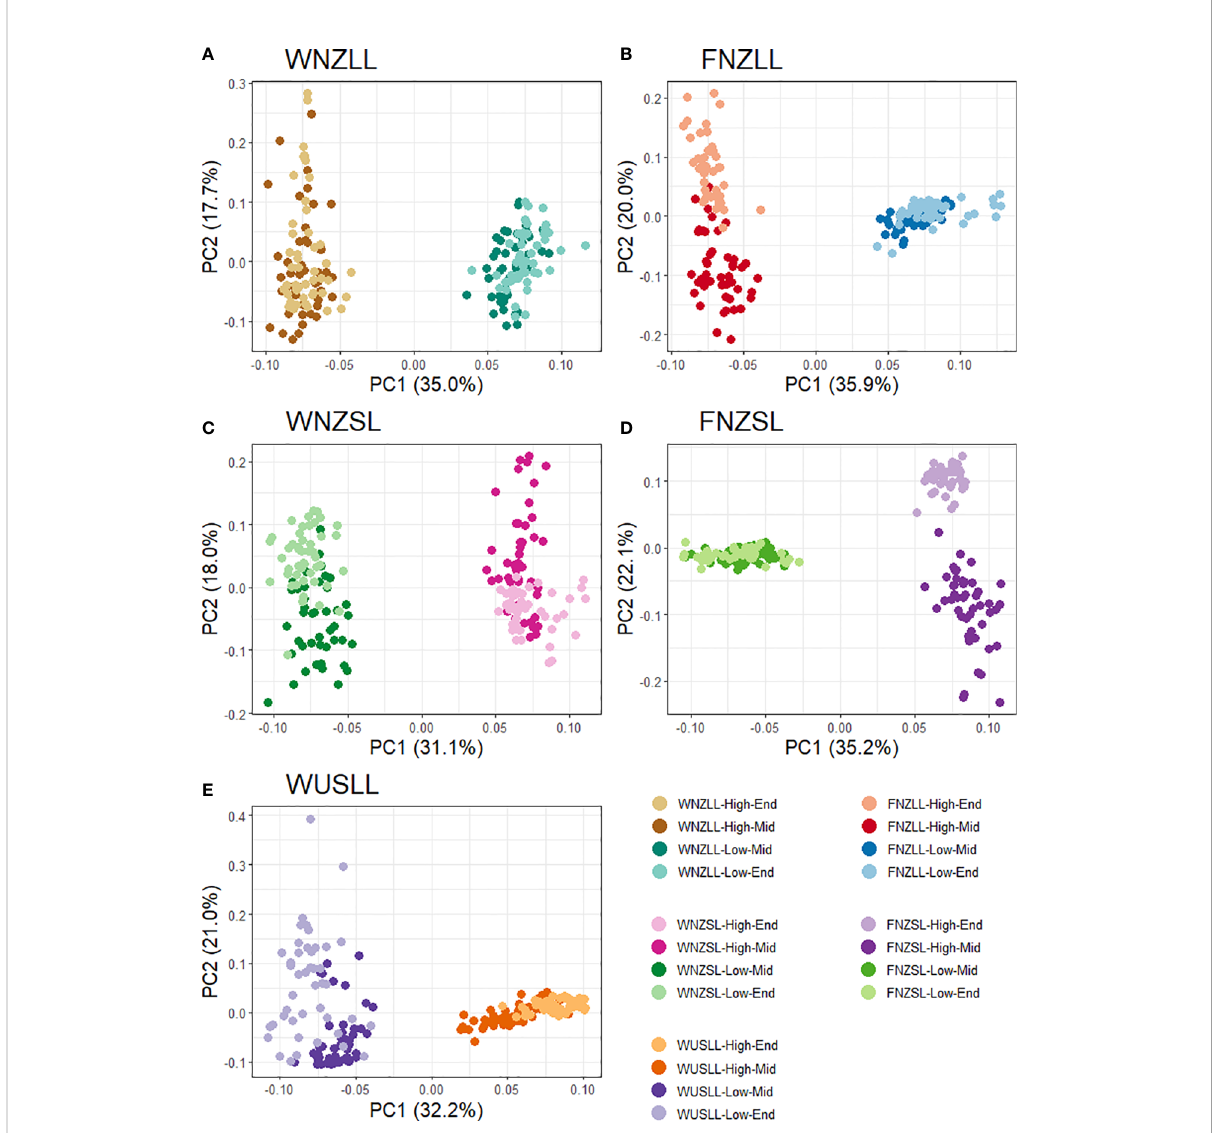
FIGURE 5 Score plots from PCAdapt analysis using the fi rst two principal components (PC) for all fi ve pools. Each dot represents an individual and the colour corresponds to individuals from the same population. Each pool has four populations as the Parent populations were excluded from the analysis. A total of 188 individuals were used from the WNZLL pool (A) , 186 from WNZSL (B) , 195 from WUSLL (C) , 182 from FNZLL (D) and 184 from FNZSL (E) , for a combined total of 935. Population information is displayed in the key in the bottom right